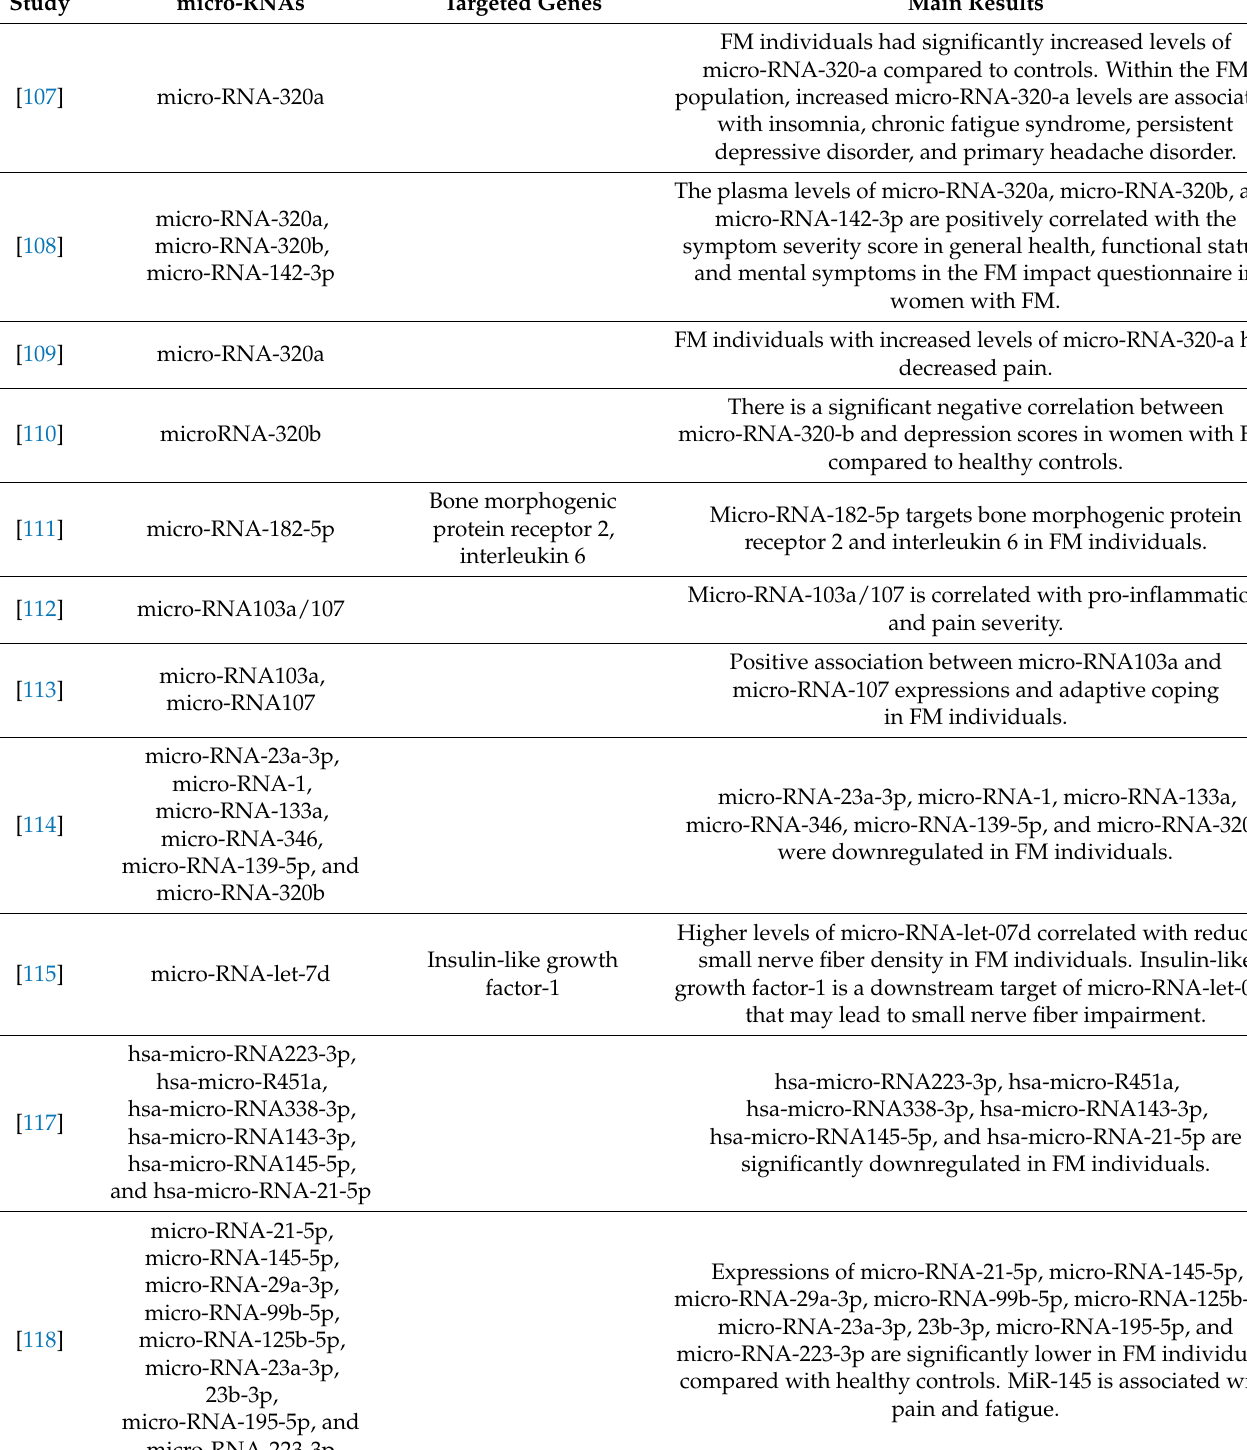
Table 5. Associations of micro-RNA and